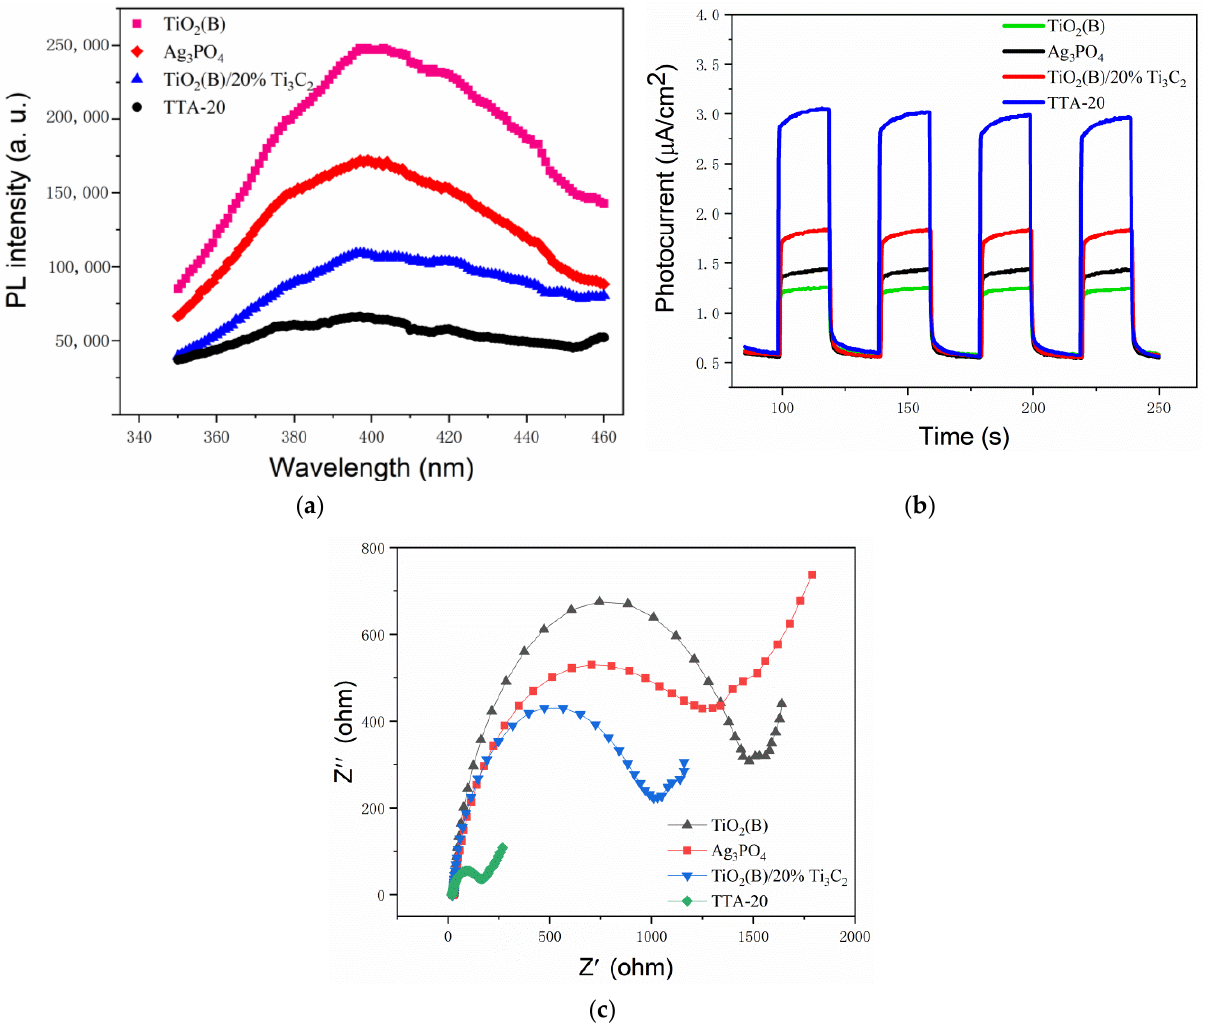
Figure 5. ( a ) Photoluminescence (PL) spectra; ( b ) transient photocurrent responses; ( c ) electrochemical impedance Nyquist.